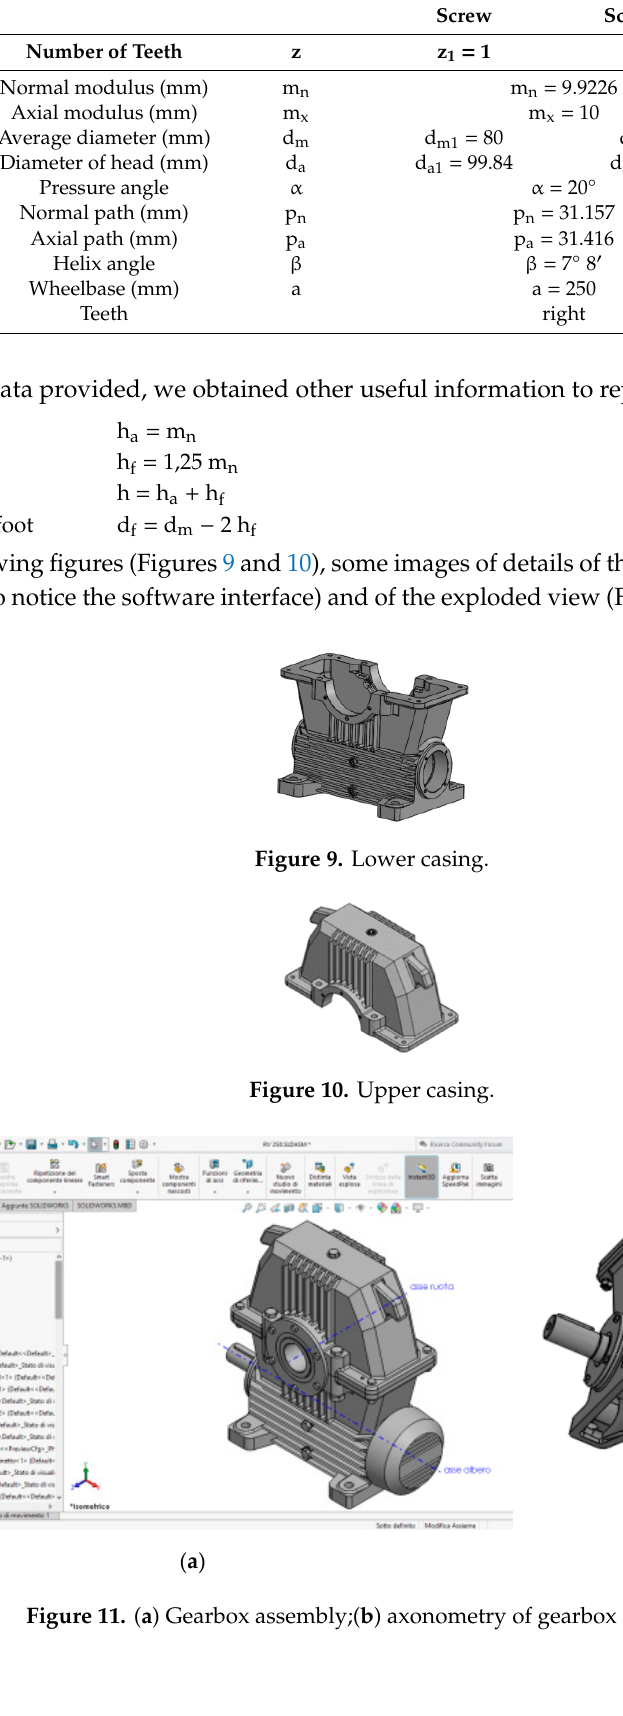
Figure 12. Exploded view. 2.1.6. Application of the First Method In this paragraph, the first method presented about the design for disassembly is applied to the case study. We wanted to perform a disassembly that allowed us to remove the drive shaft with an endless screw, which was considered our target component. The choice of the screw as a target component is reasonable because it is one of the components most subjected to stress and wear. For this reason, it is more likely that it will fail or in any case be replaced to perform preventive maintenance. In order to remove the shaft, the lower casing was not taken into consideration as it provides the support base to our gearbox, and the screw is contained inside.